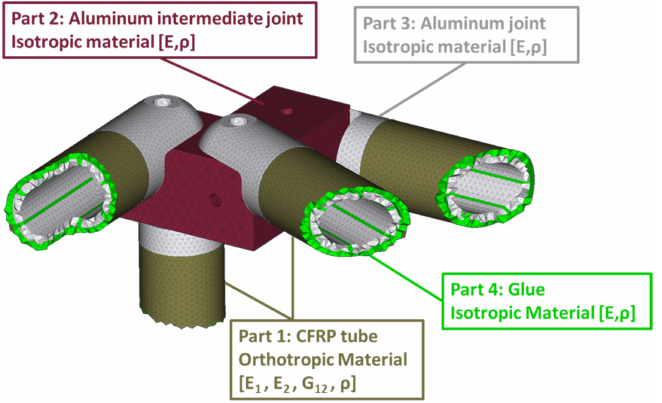
Figure 5. Parameterized FE model.